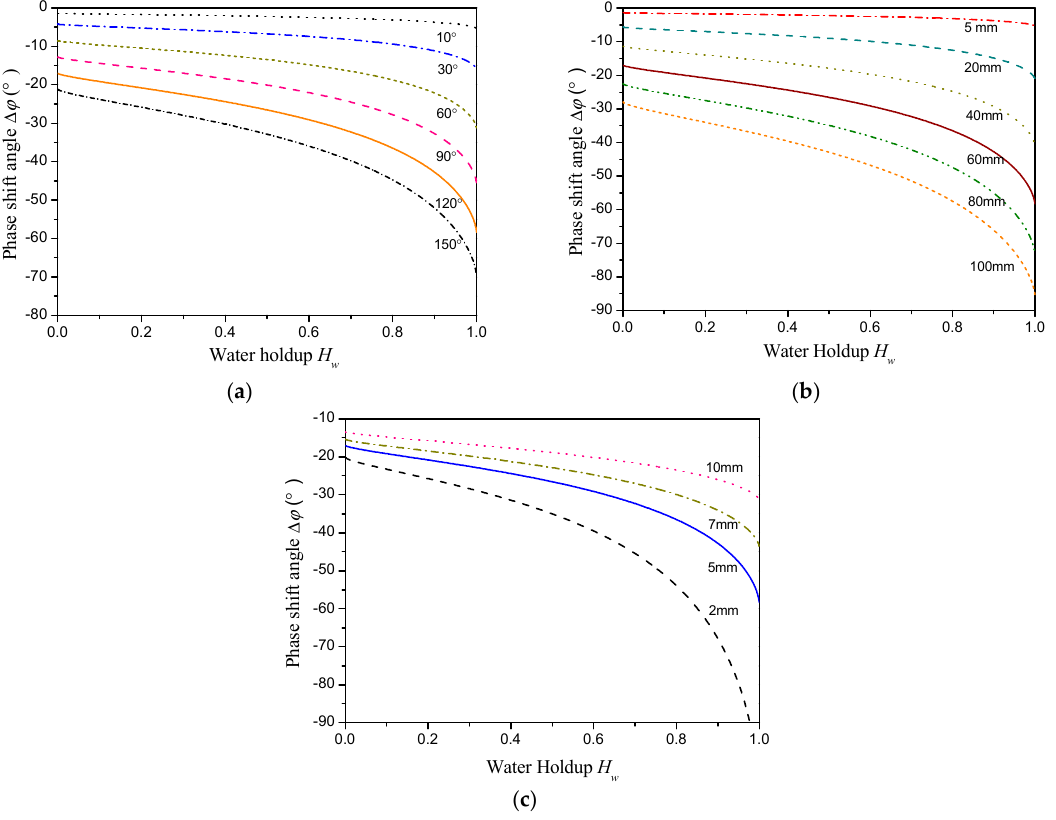
Figure 9. Phase shift responses of the CCS with different geometric parameters. ( a ) With different electrode angles; ( b ) with different electrode lengths; ( c ) with different pipe wall thicknesses.